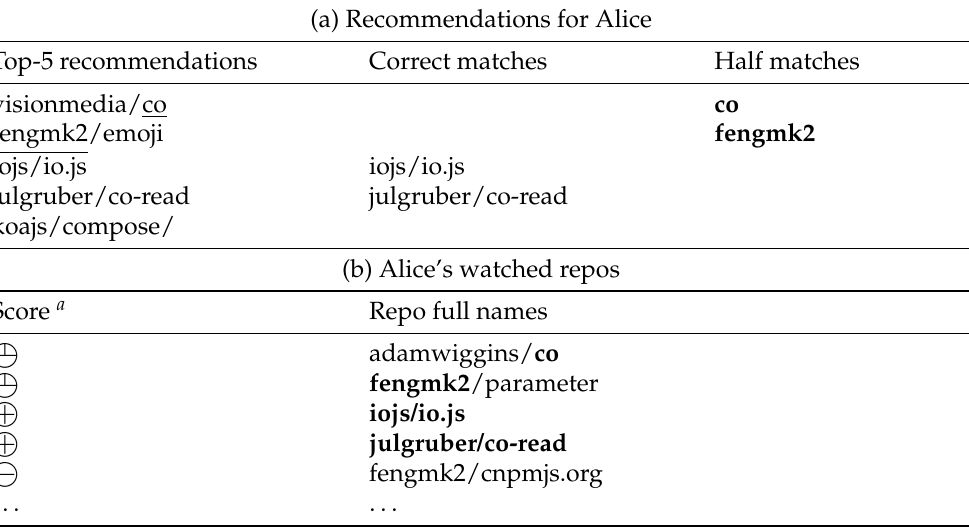
Table 6. A sample scenario for recommending with correct and half